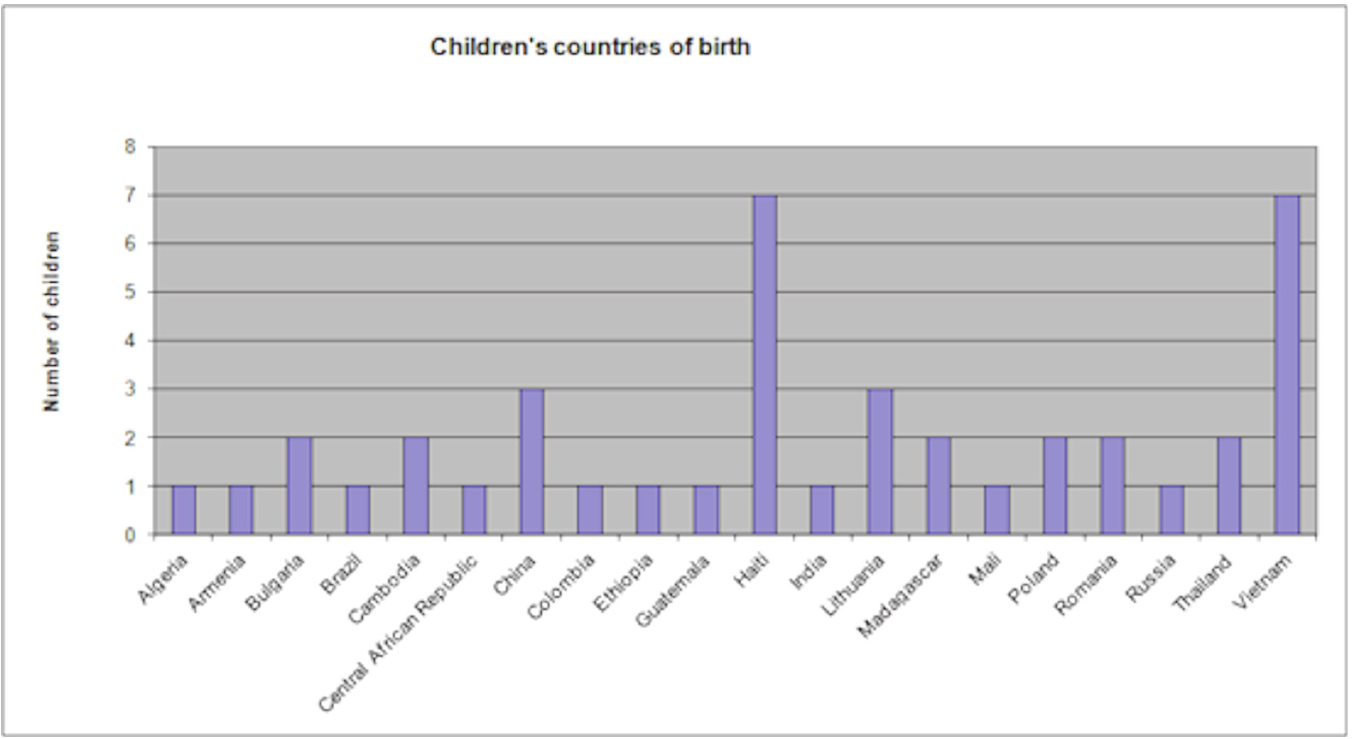
Fig 1. Children ’ s countries of birth. Fig. 1 describes the countries of birth of the children adopted by parents included in this study. One child was adopted in Algeria, 1 in Armenia, 2 in Bulgaria, 1 in Brazil, 2 in Cambodia, 1 in Central African Republic, 3 in China, 1 in Colombia, 1 in Ethiopia, 1 in Guatemala, 7 in Haiti, 1 in India, 3 in Lithuania, 2 in Madagascar, 1 in Mali, 2 in Poland, 2 in Romania, 1 in Russia, 2 in Thailand, and 7 in